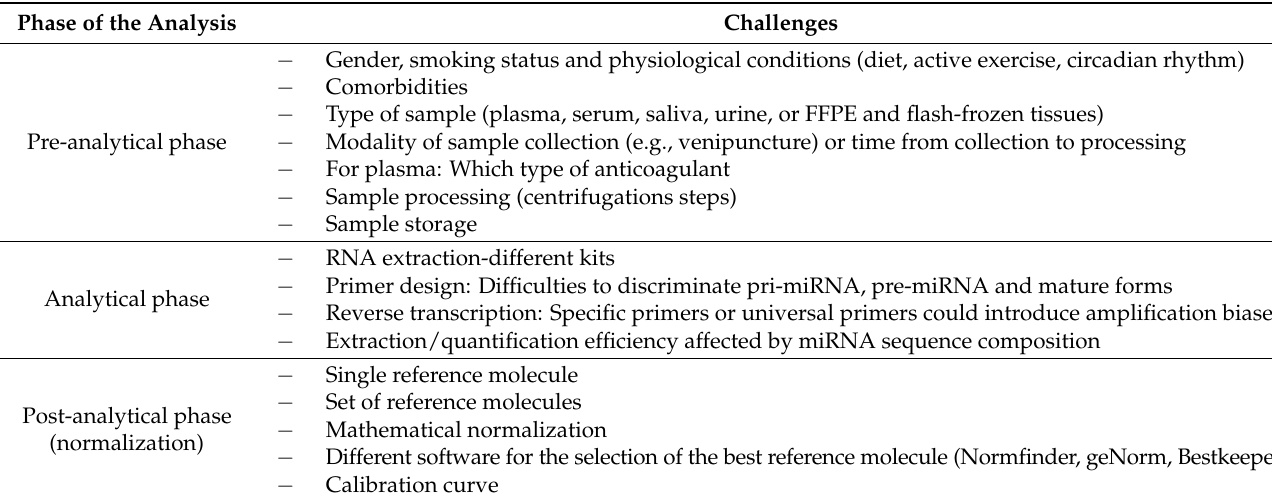
Table 1. Summary of the different technical limitations during miRNA quantification.